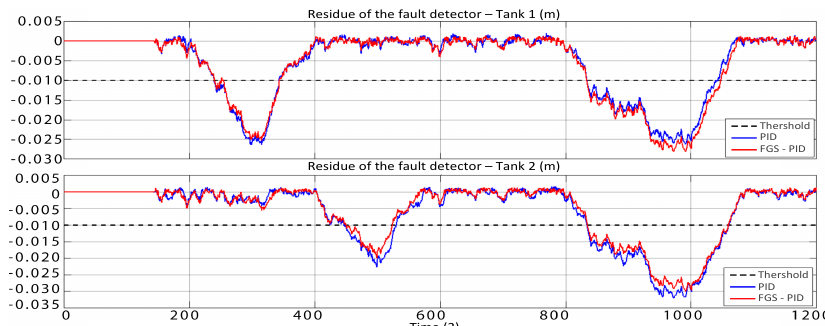
Figure 9. Residue simulation results to evaluate fault